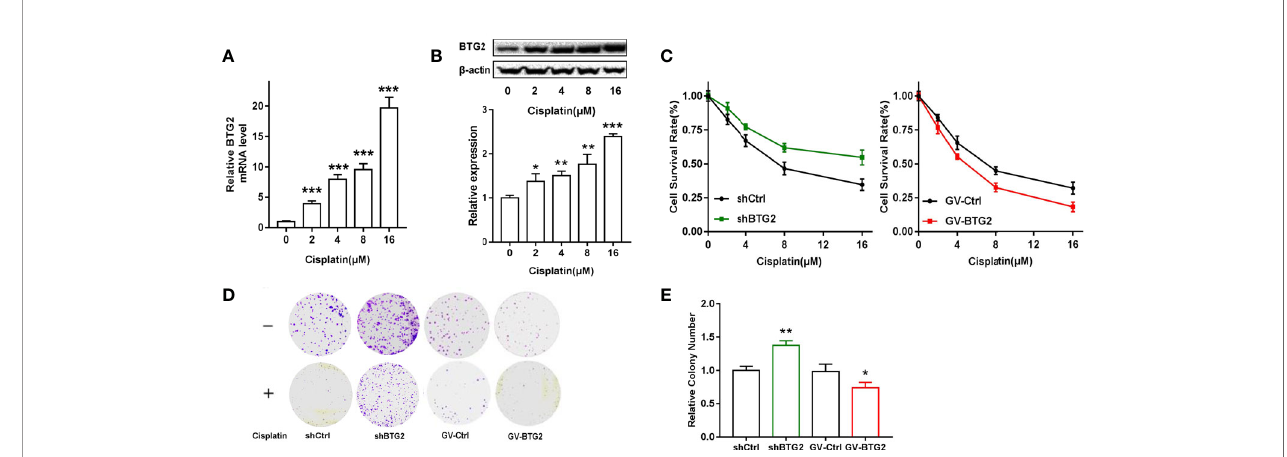
FIGURE 6 | BTG2 impairs the viability and colony formation of cisplatin-treated A2780 cells. (A) A2780 cells were treated with cisplatin (0, 2, 4, 8, 16 m M) for 48h. Quantitative real-time PCR assay showed mRNA levels of BTG2 after cisplatin treatment. (B) A2780 cells were treated with cisplatin (0, 2, 4, 8, 16 m M) for 48h Western blot showed protein levels of BTG2 after cisplatin treatment. (C) Cisplatin induced cell viability of A2780 cells was detected by MTT assay. (D) Cells were treated with or without cisplatin (2 m M) for 15 days and the remained colonies were stained and counted. (E) The colony number was relative to negative control cells.